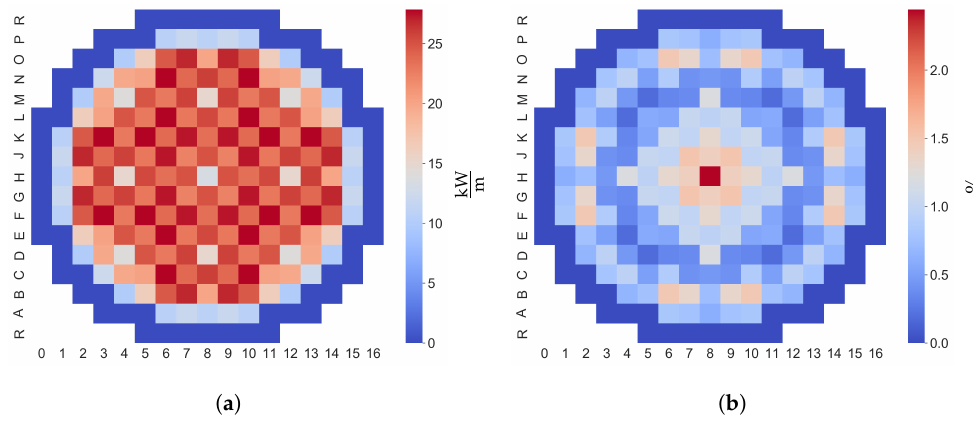
Figure 30. Radial profile of P ave